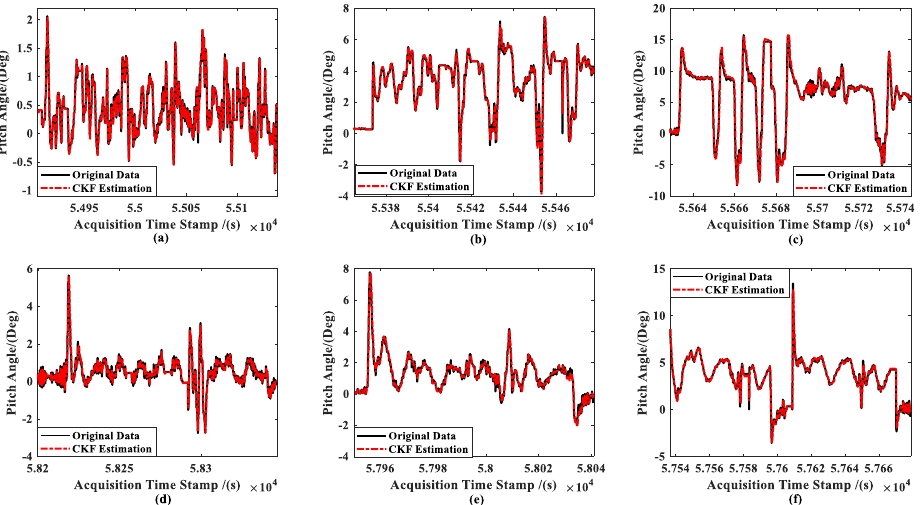
Figure 9. CKF estimation results for the ship’s attitude: ( a ) slow speed of MRM, ( b ) medium speed of MRM, ( c ) high speed of MRM, ( d ) slow speed of ANM, ( e ) medium speed of ANM, and ( f ) high speed of ANM.